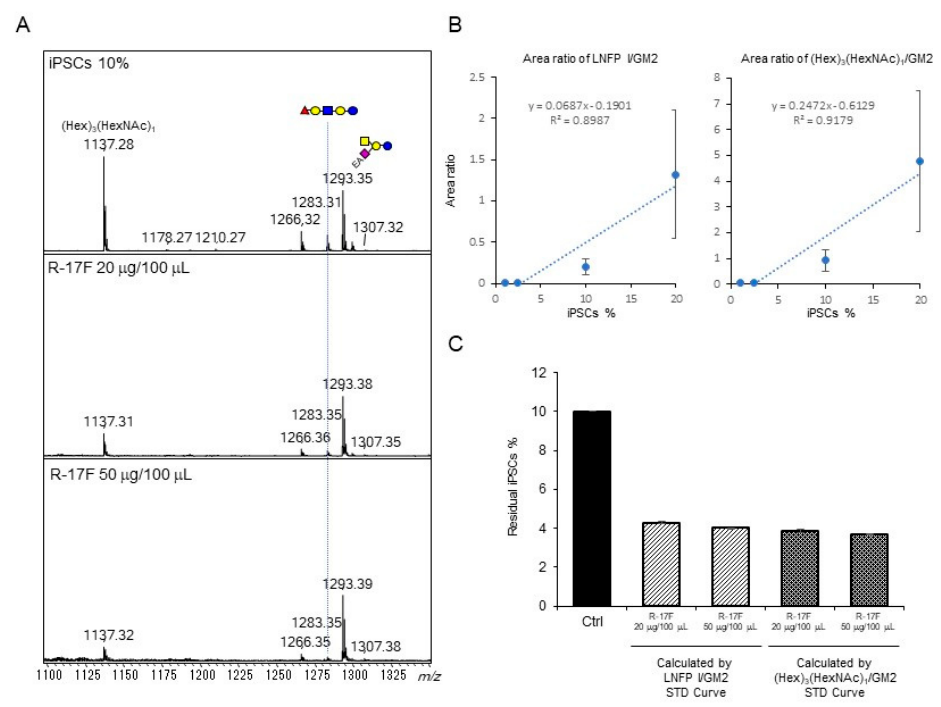
Figure 6. MALDI-TOF MS analysis of GSL-glycans from co-cultured cells (chondrocytes and iPSCs) treated with R17-F antibody. ( A ) MALDI-TOF MS spectra of co-cultured cells and antibody-treated cells. ( B ) Linear dynamic ranges of LNFP I / GM2 and (Hex) 3 (HexNAc) 1 / GM2 area ratios at di ff erent iPSC co-cultured conditions (iPSC content = 20%, 10%, 2.5%, and 1%). ( C ) Evaluation of residual iPSCs co-cultured with chondrocytes. The residual iPSC percentage was calculated using calibration curves. Error bars indicate standard deviation (SD) for triplicate measurement.